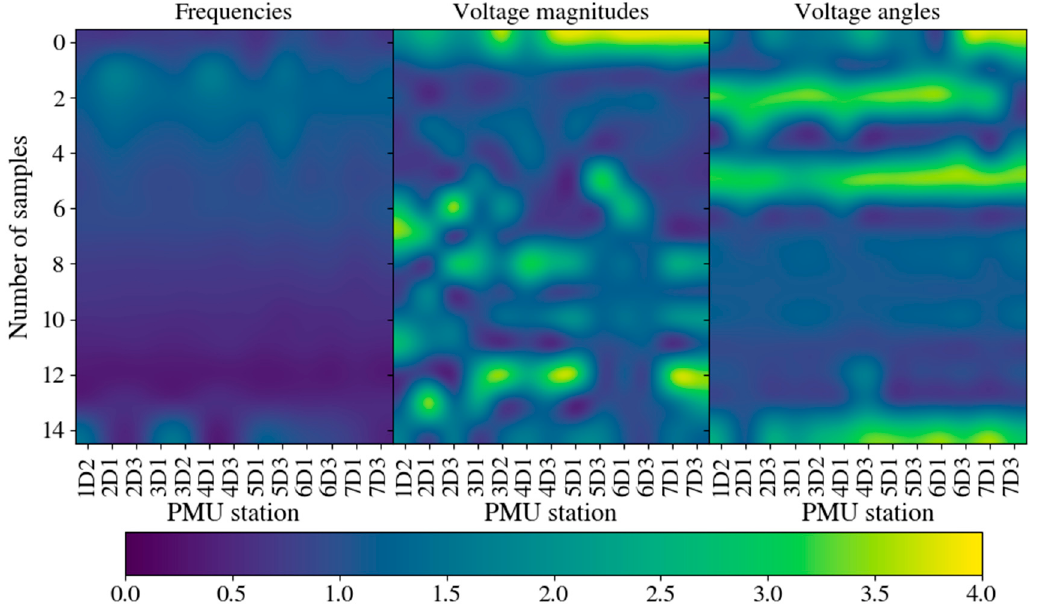
Figure 18. Anomaly scores for selected PMU samples from a line outage at L32.